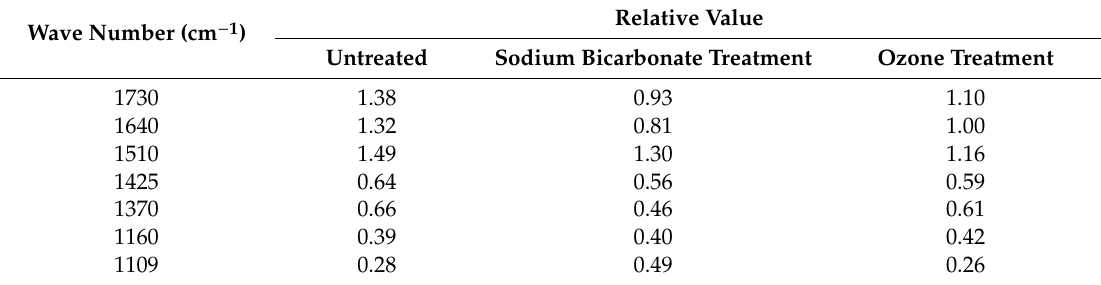
Table 2. The value of main infrared spectral bands of RP relative to the reference